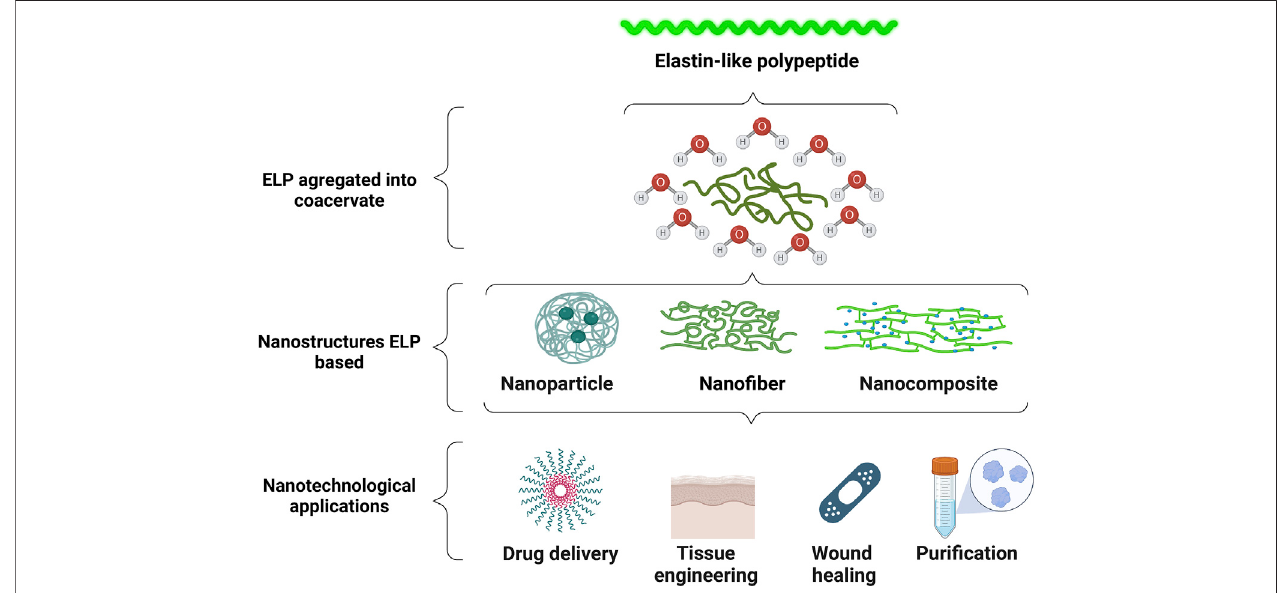
FIGURE 3 | ELPs aggregated coacervate involved in water molecules in a conformation in different types of nanostructures that can be used in various nanotechnological applications. Created with BioRender.com.